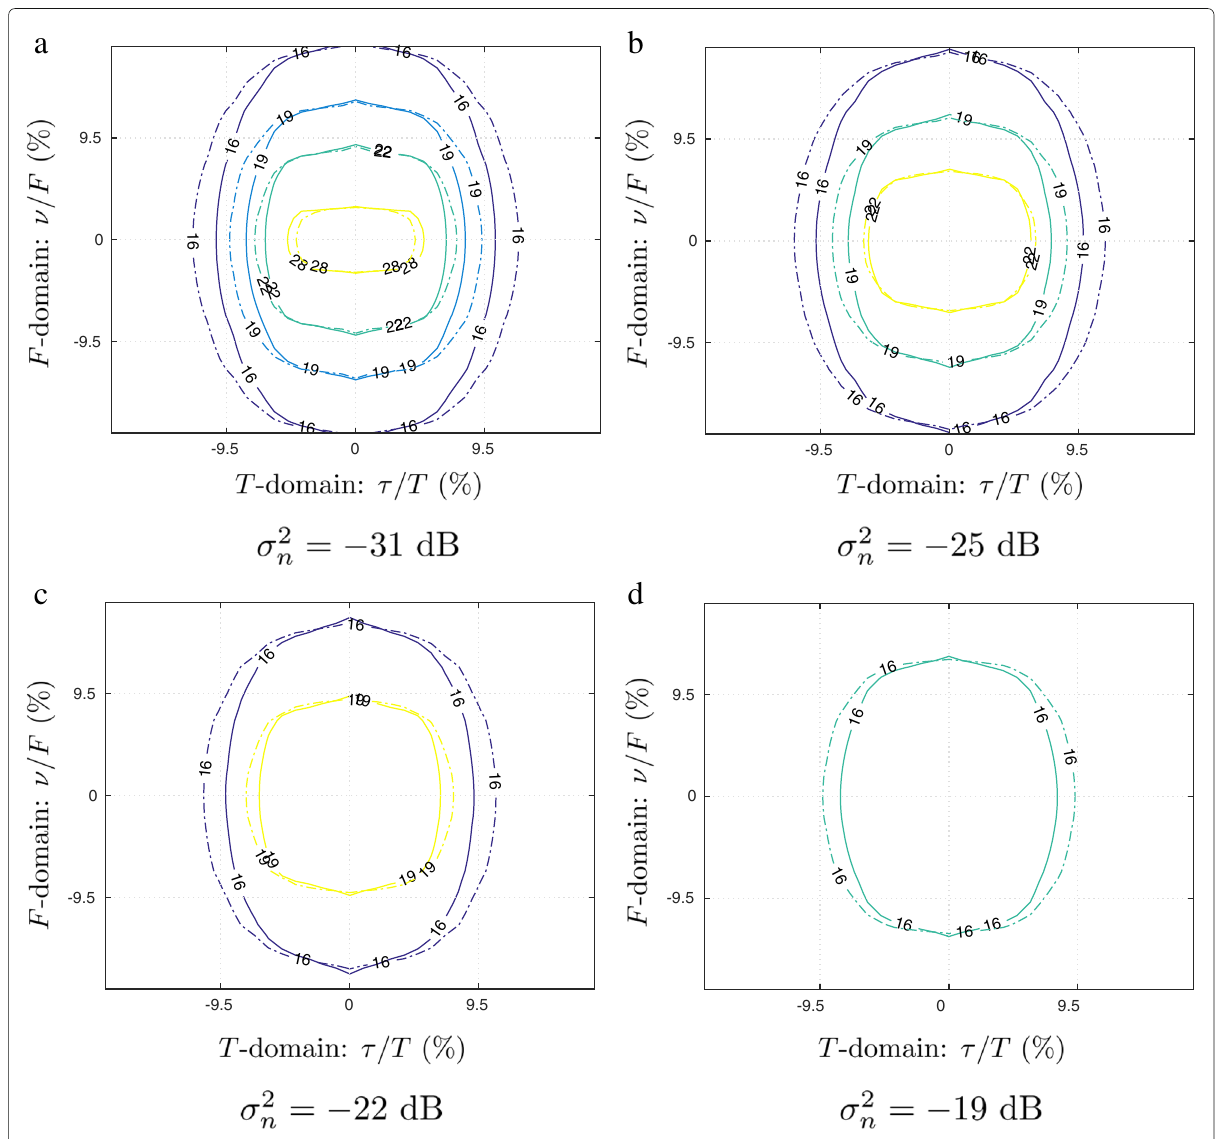
Fig. 11 a – d SINR contour of g cpofdm ( solid ) and g K = 1.07 1 ( dashed ) w.r.t. max-SINR